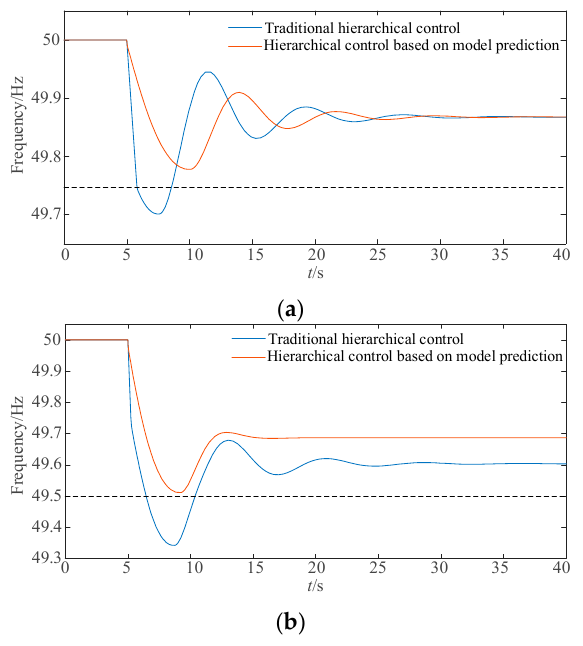
Traditional hierarchical control Hierarchical control based on model prediction